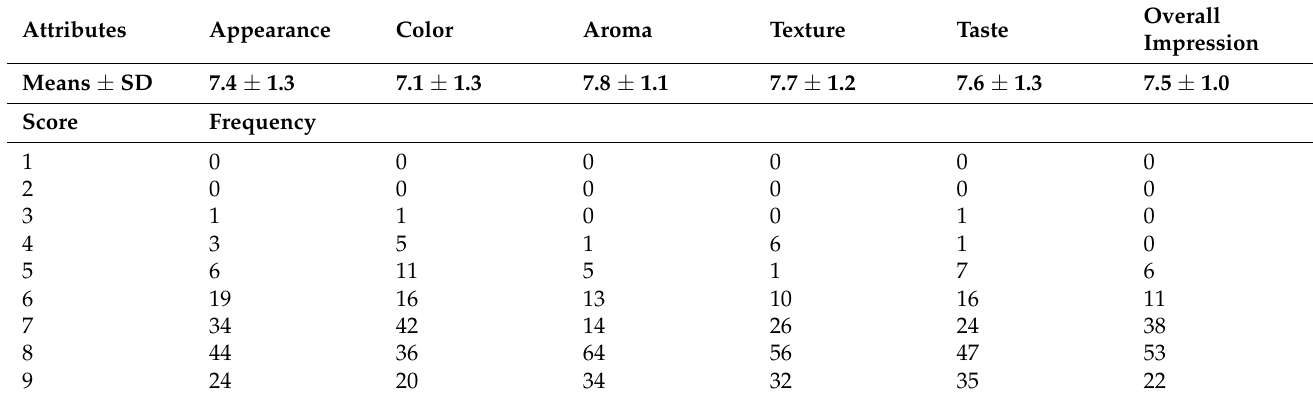
Table 4. Sensory acceptance of sweetened plain whole-fat yogurts with addition of jabuticaba skin powdered extract at 0.5 g/100 g concentration